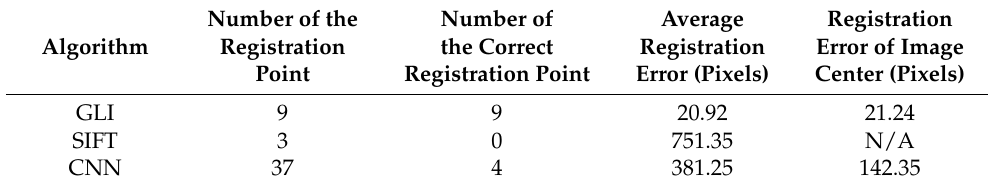
Table 6. Comparative analysis of experimental results.